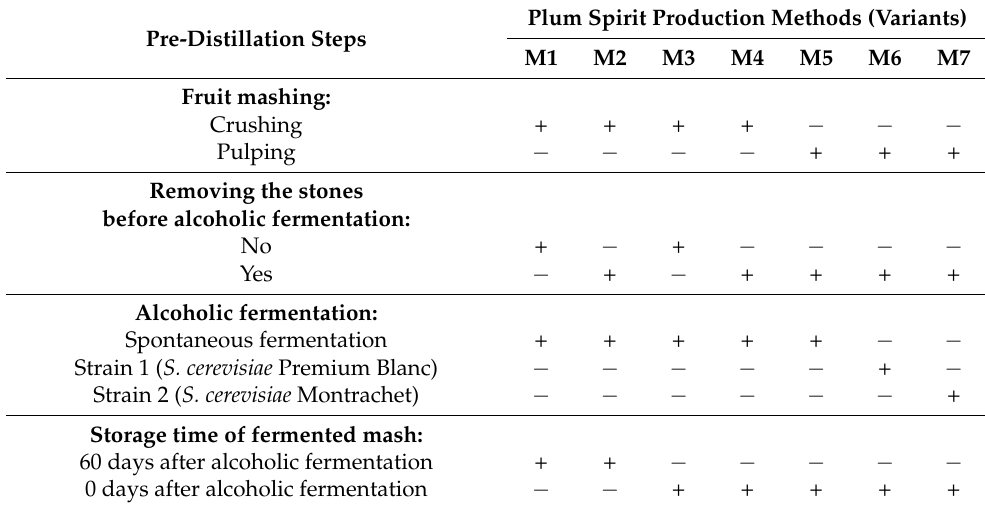
Table 1. Traditional (M1) and modified (M2–M7) plum spirit production